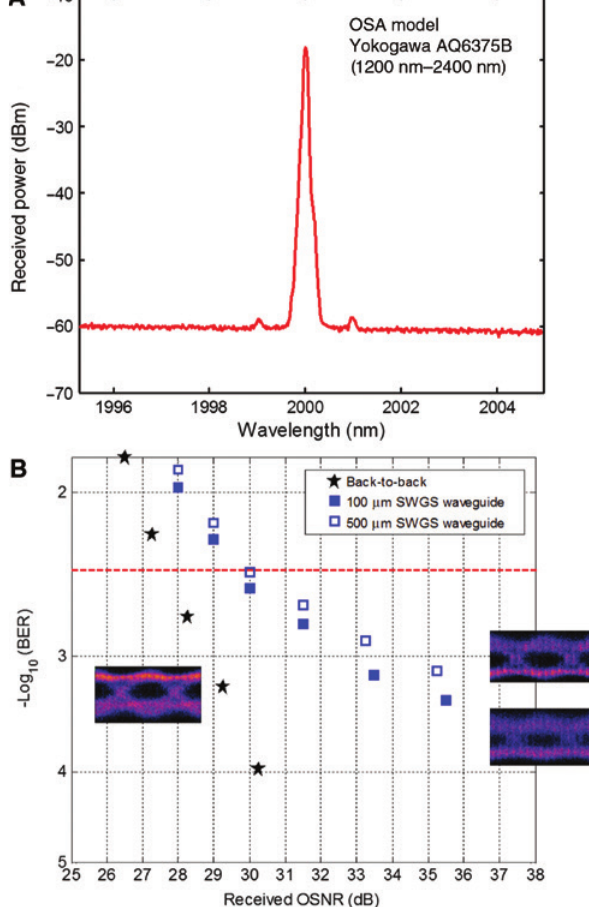
Figure 9: Experimental results. (A) Measured spectrum after filter and VOA in Figure 8. (B) Measured BER vs. received OSNR and eye diagrams for chip-scale data trans- mission through 100- μ m and 500- μ m SWGS